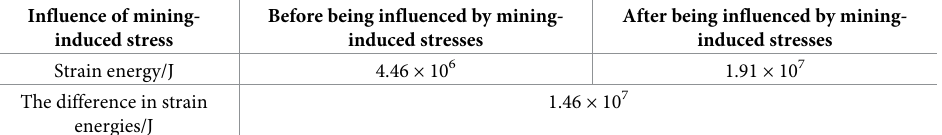
Table 7. Distributions of plastic zone shape and strain energy density in the rock surrounding the roadway with a failure length of 1 m under the effect of mining-induced